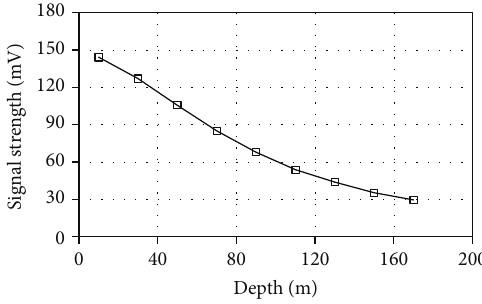
Figure 3: Relationship between received signal strength and downhole depth of the signal transmitter.